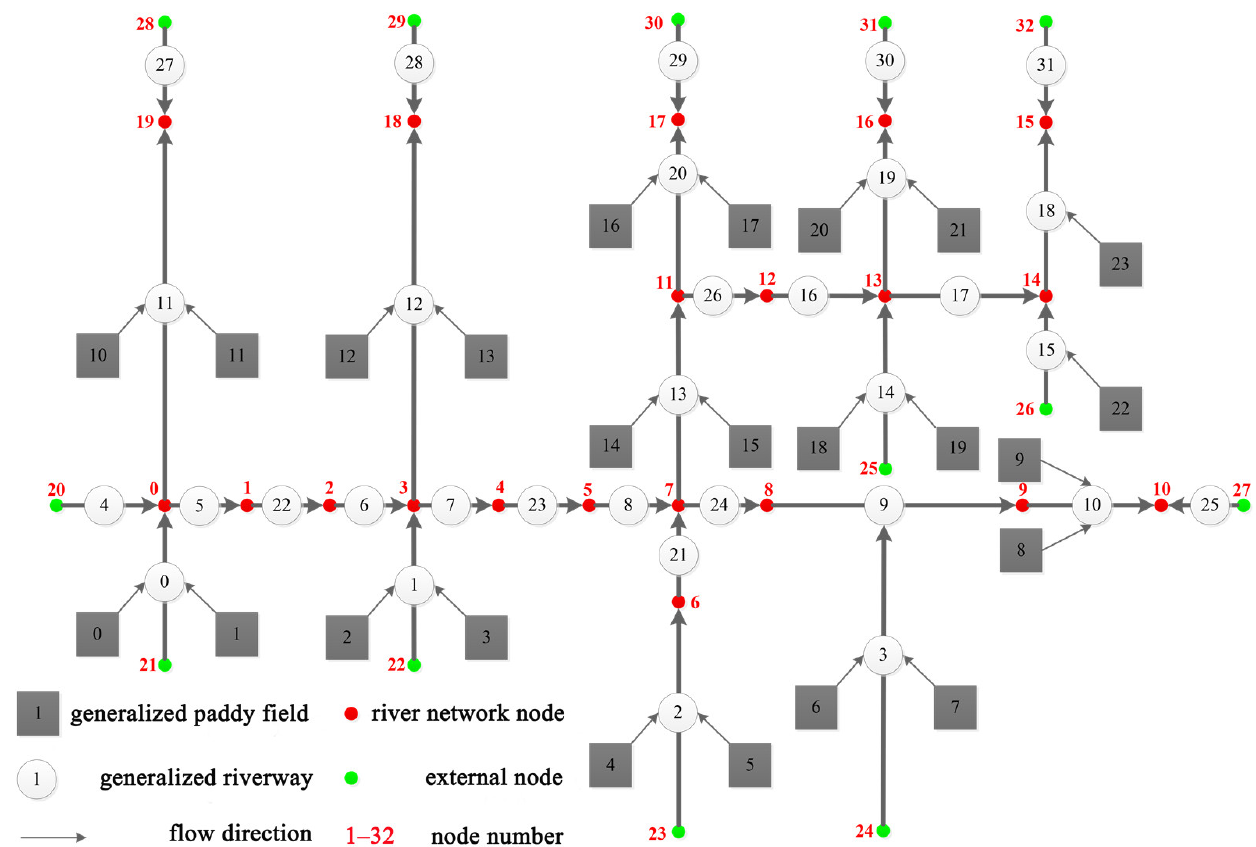
Figure 3. Flowchart of the drainage system for waterlogging removal in the study area.